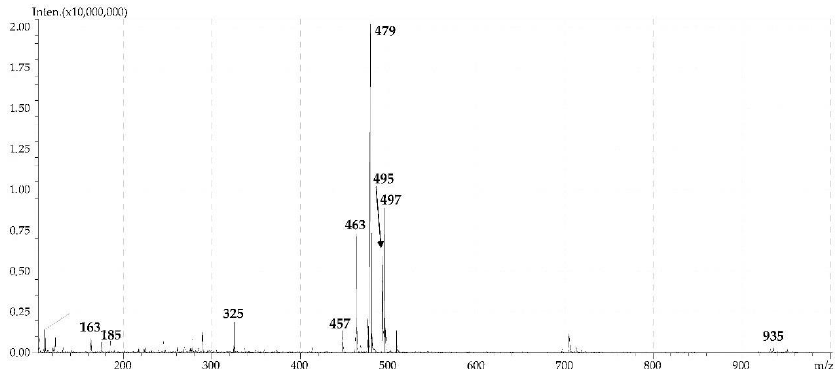
Figure 7. ESI-MS spectrum (positive ionization) of umbelliferone-7- O - (6′′ -apiosyl)-glucoside (6′′ -apiosylskimmin, 27 ).